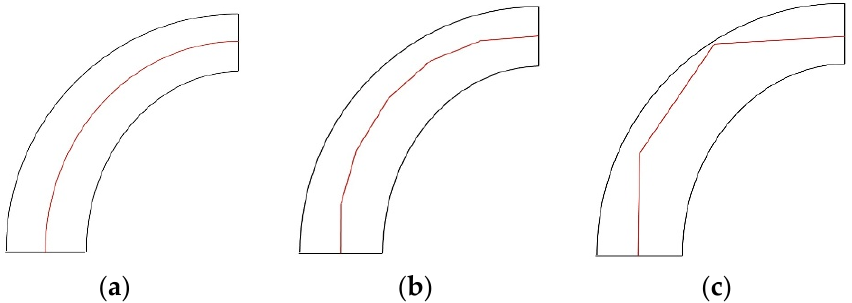
Figure 17. Three X-Z topological paths of a spiral stair: ( a ) s = 10 cm, ( b ) s = 40 cm, and ( c ) s = 100 cm.